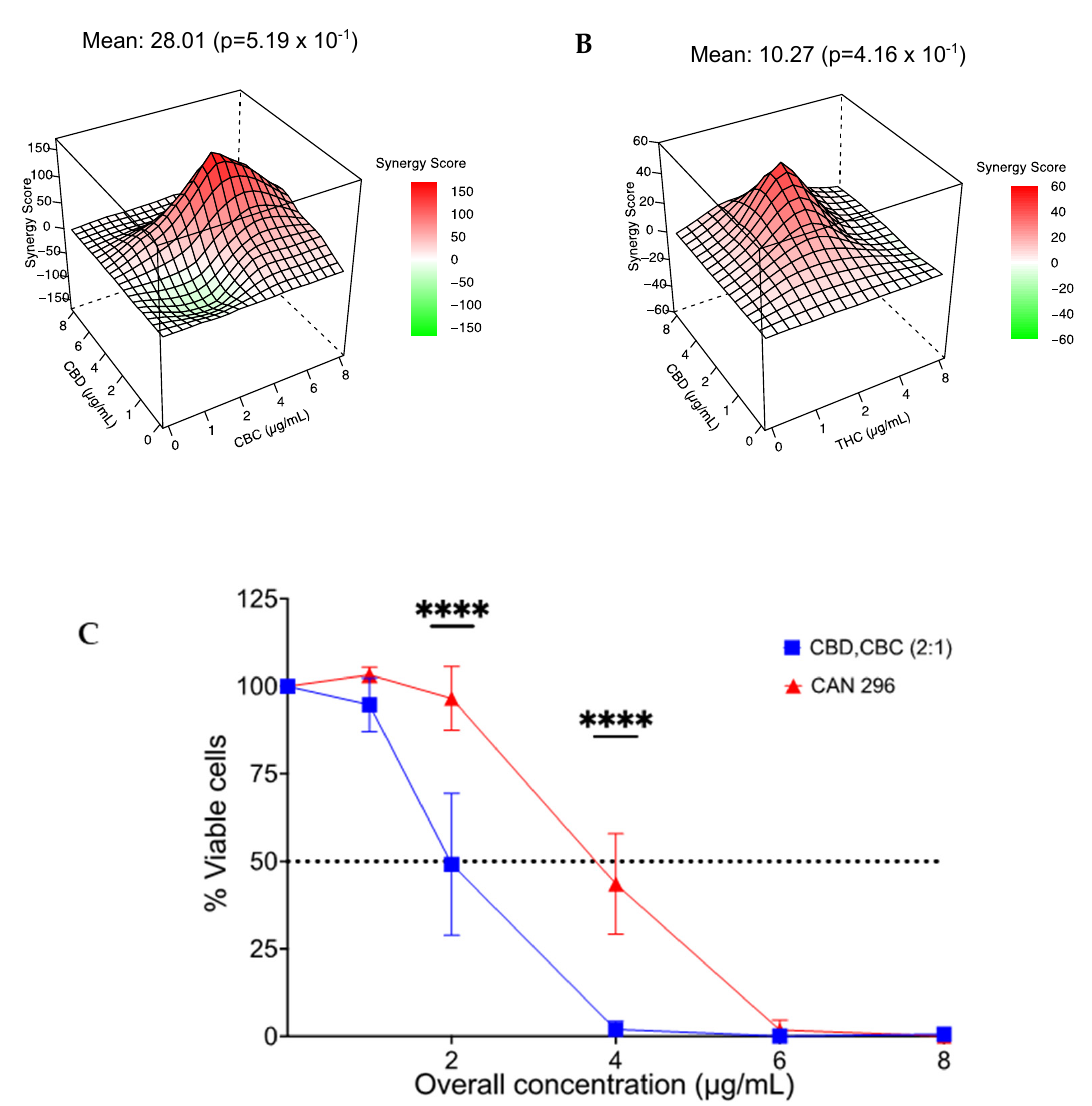
Figure 8. CBD and CBC combination (2:1 ratio) is more effective than CAN296. The Bliss model synergy distribution for ( A ) CBD-CBC, and ( B ) CBD-THC, was calculated with the SynergyFinder web application (v 2.0). Data are reported as a 3D Visualization synergy map in a bliss synergy mode, with multiplicative effect as if the two cannabinoids act independently. Cell death was assessed by MTT cell viability assay (n = 3). ( C ) A dose-response curve of cell line Scc25 following 24 h of treatment with CAN296 extract vs. treatment with CBD and CBC cannabinoid combination at the synergistic ratio of 2:1. Data are reported as mean ± SE (n = 6) of % viable cells compared to control. Asterisks indicate statistical significance in cell viability between treatments (**** p < 0.0001, two-way ANOVA with Sidak multiple comparison tests).